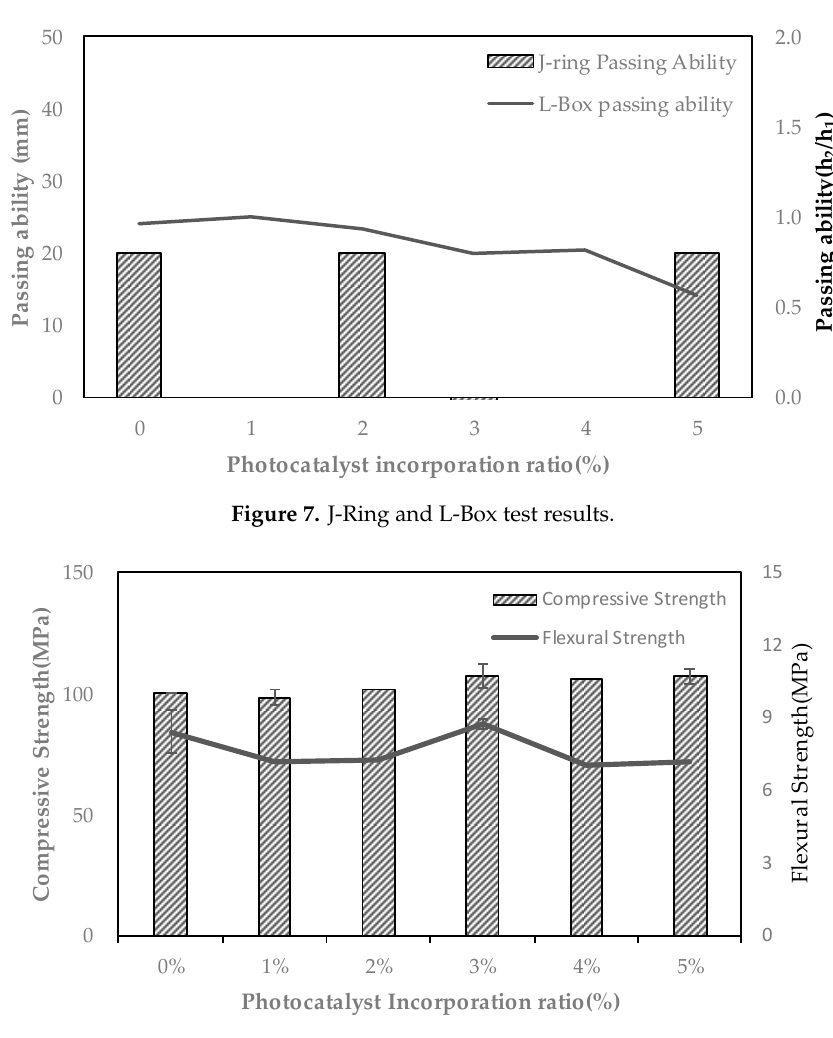
Figure 8. Compressive and flexural strength results.